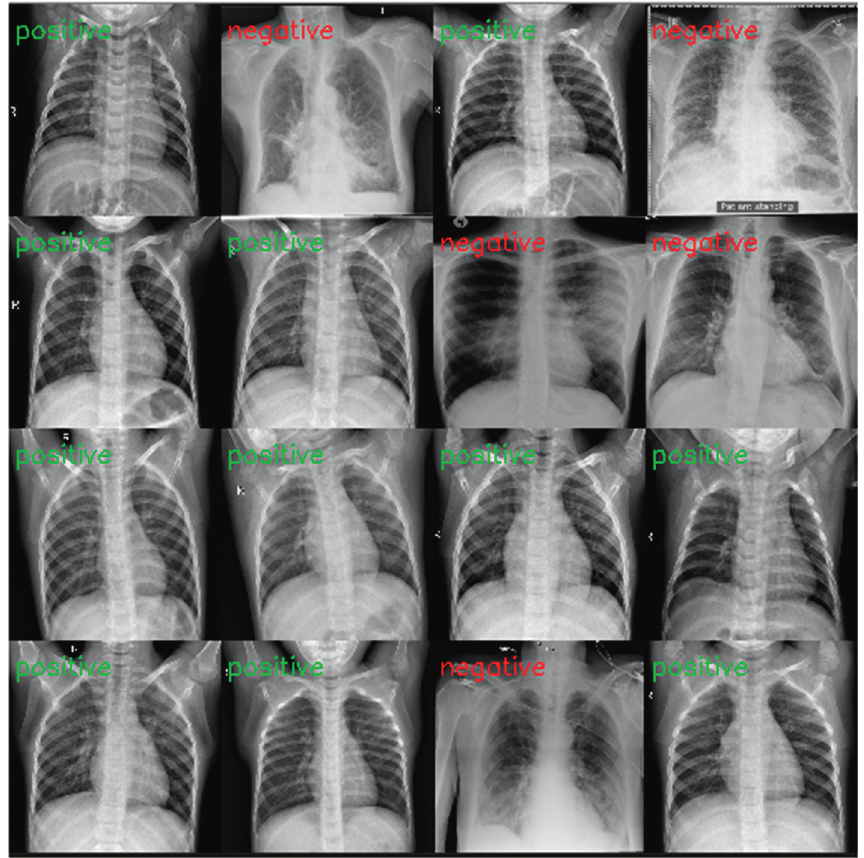
Figure 7: Tested VGG19